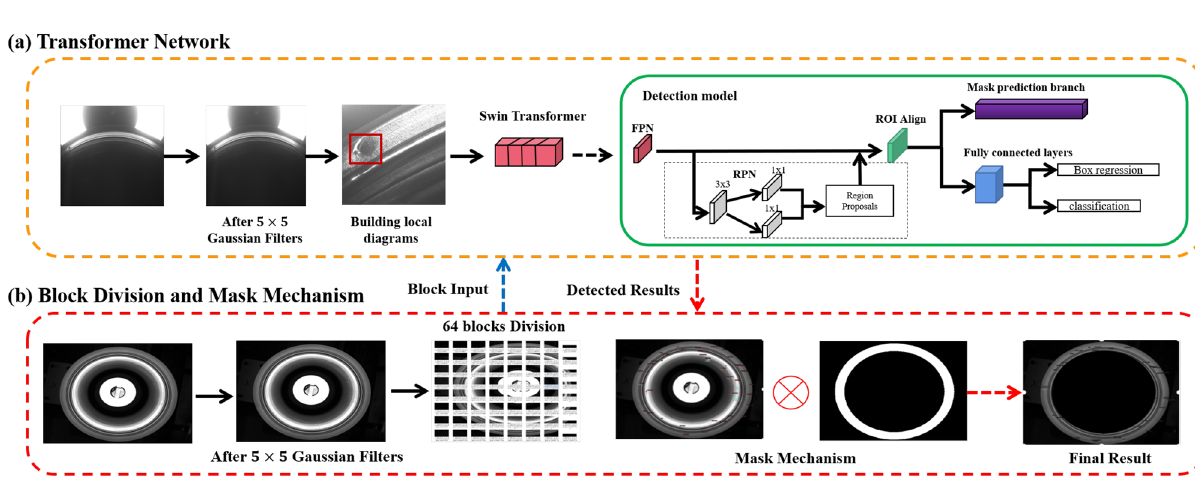
Figure 4. The local enlarged region of the cylinder liner, where the defect is located inside the red rectangle.